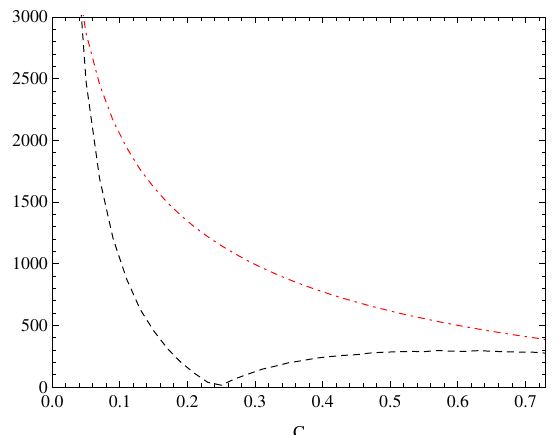
¯ B ( y, µ r ) β · β 0 and conformal term 0 ¯ B ( y, µ r ) con , and the